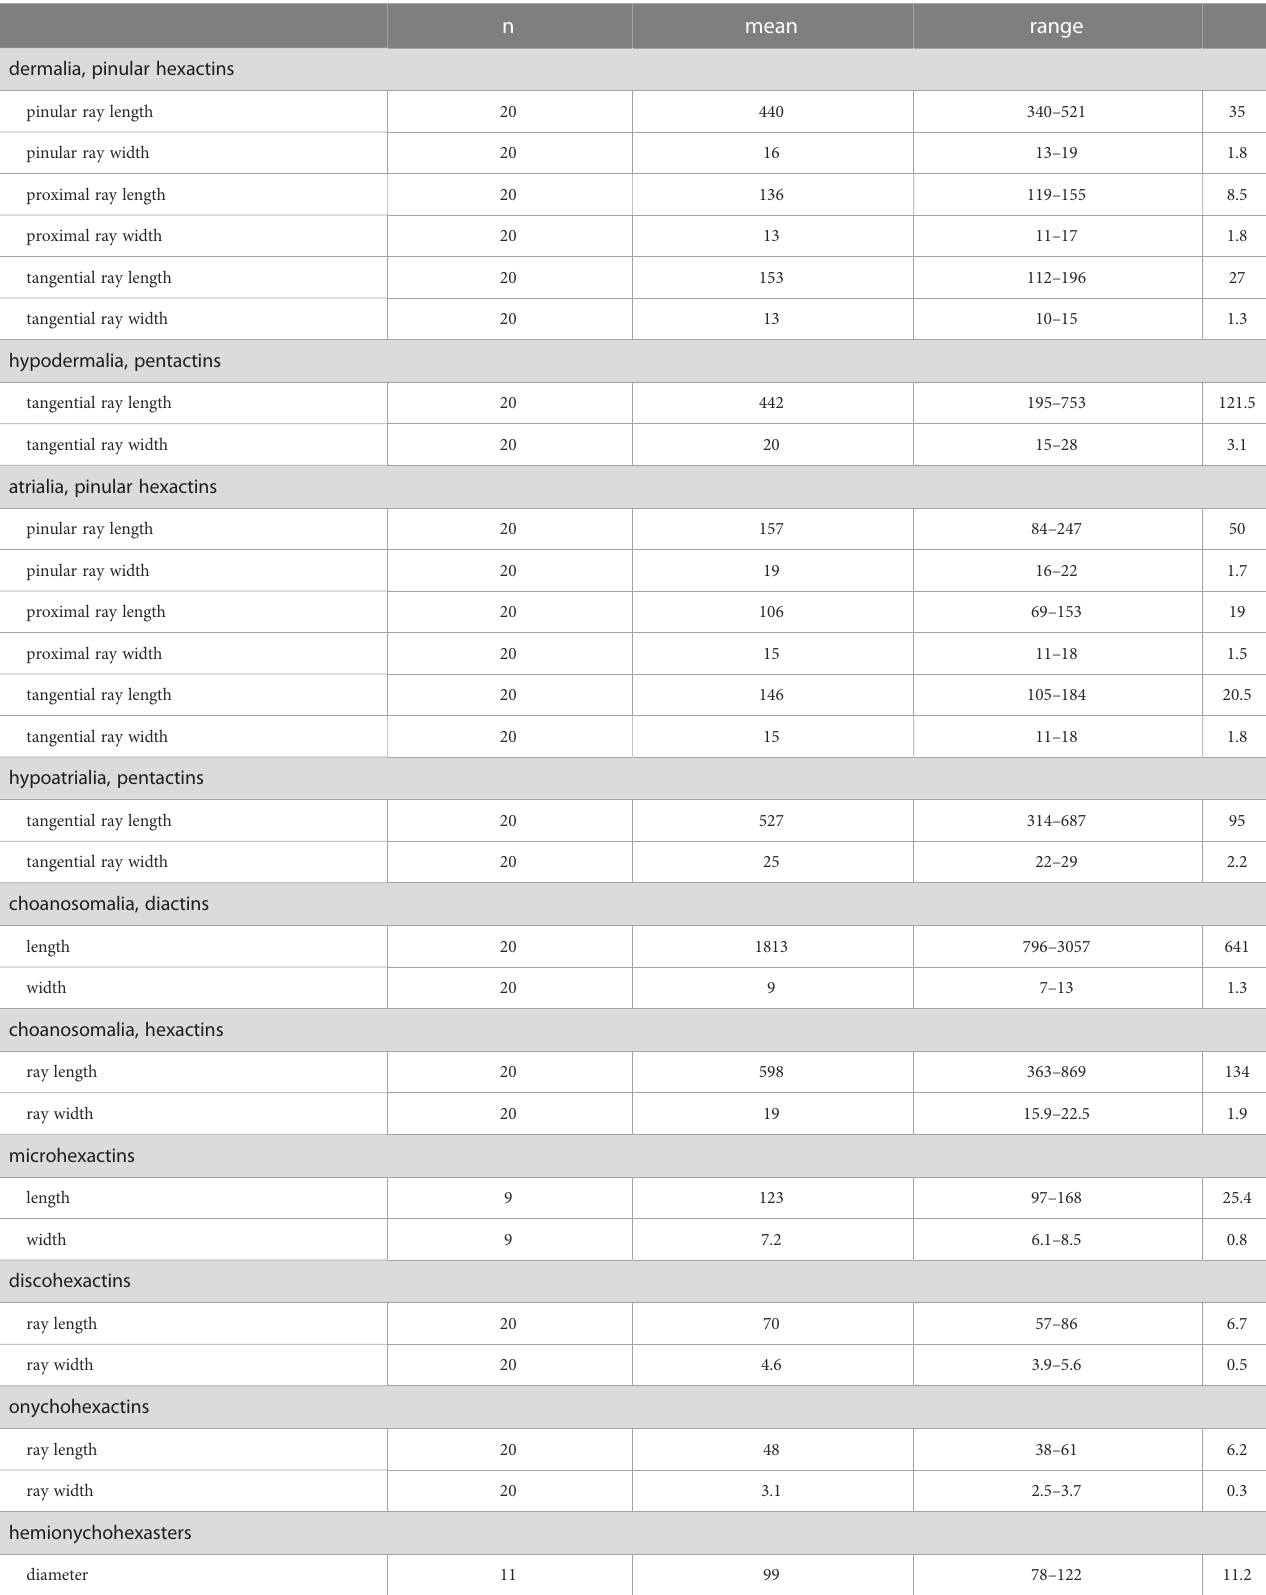
TABLE 1 Measurements of the spicules of Caulophacus (Caulodiscus) iocasicus sp. nov. (in µm); “ n ” , number of spicules measured; “ s.d. ” , standard deviation; “ range ” , range from the minimum to the maximum. n mean range s.